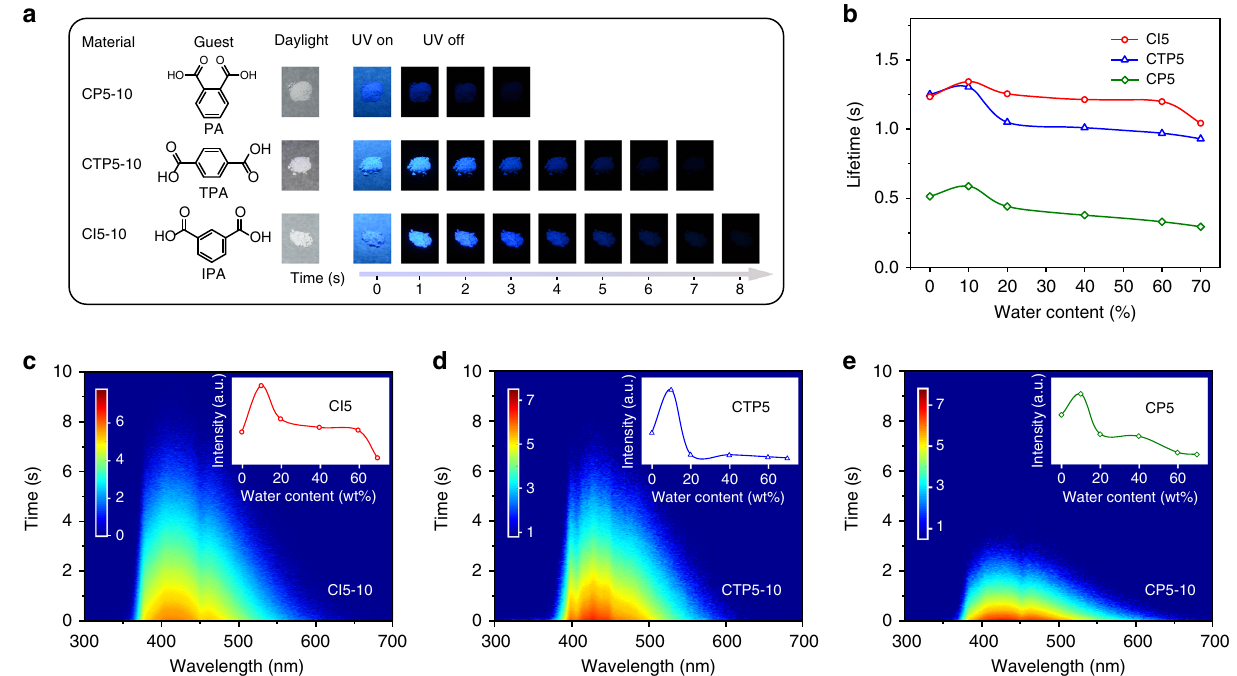
Fig. 4 Universality of the deep-blue OURTP design strategy. a Chemical structures of guest molecules and photographs of CI5-10, CTP5-10, and CP5-10 taken under daylight, UV light (UV on) and after removal of excitation (UV off) for several seconds. b Lifetimes of CI5, CTP5, and CP5 with various water contents. c – e Time-resolved emission scanning spectra of CI5-10 ( c ), CTP5-10 ( d ), and CP5-10 ( e ). Insets: phosphorescence intensities of CI5, CTP5, and CP5 with various water